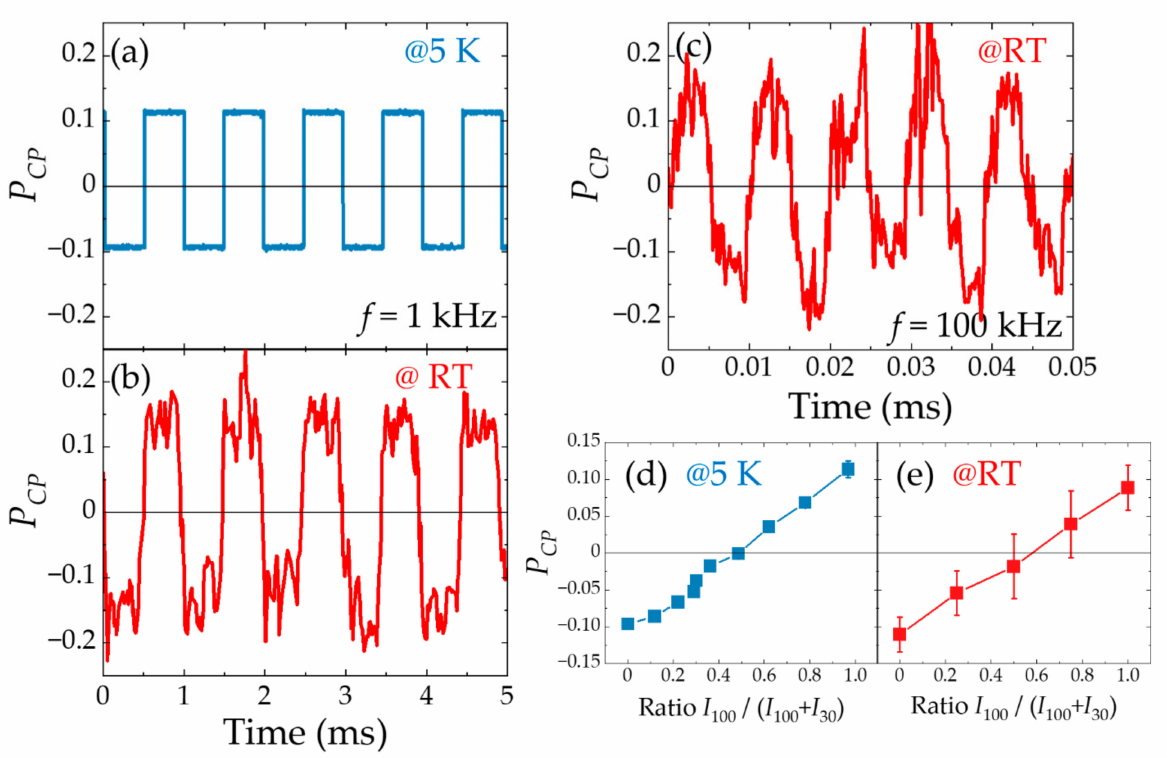
Figure 6. Experimental data for electrical polarization switching by sending square current waves into two electrodes with frequency f = 1 kHz at ( a ) 5 K and ( b ) RT, and ( c ) f = 100 kHz at RT. ( d ) , ( e ) Experimental results for arbitrary polarization control at ( d ) 5 K and ( e ) RT. The horizontal axis shows the EL intensity ratio I 100 /( I 100 + I 30 ). Reproduced with permission from